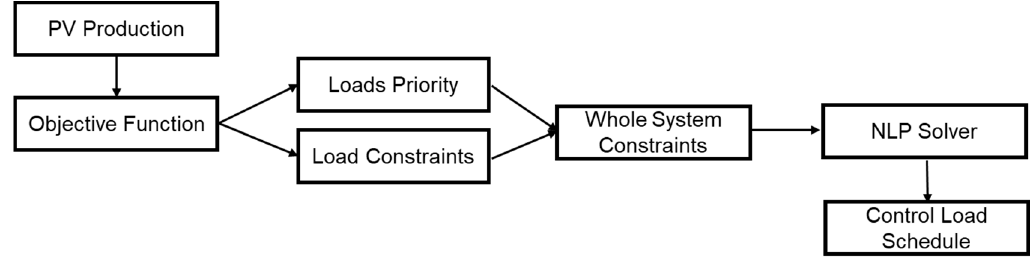
Figure 22. The architecture of the NLP-based load optimization algorithm.